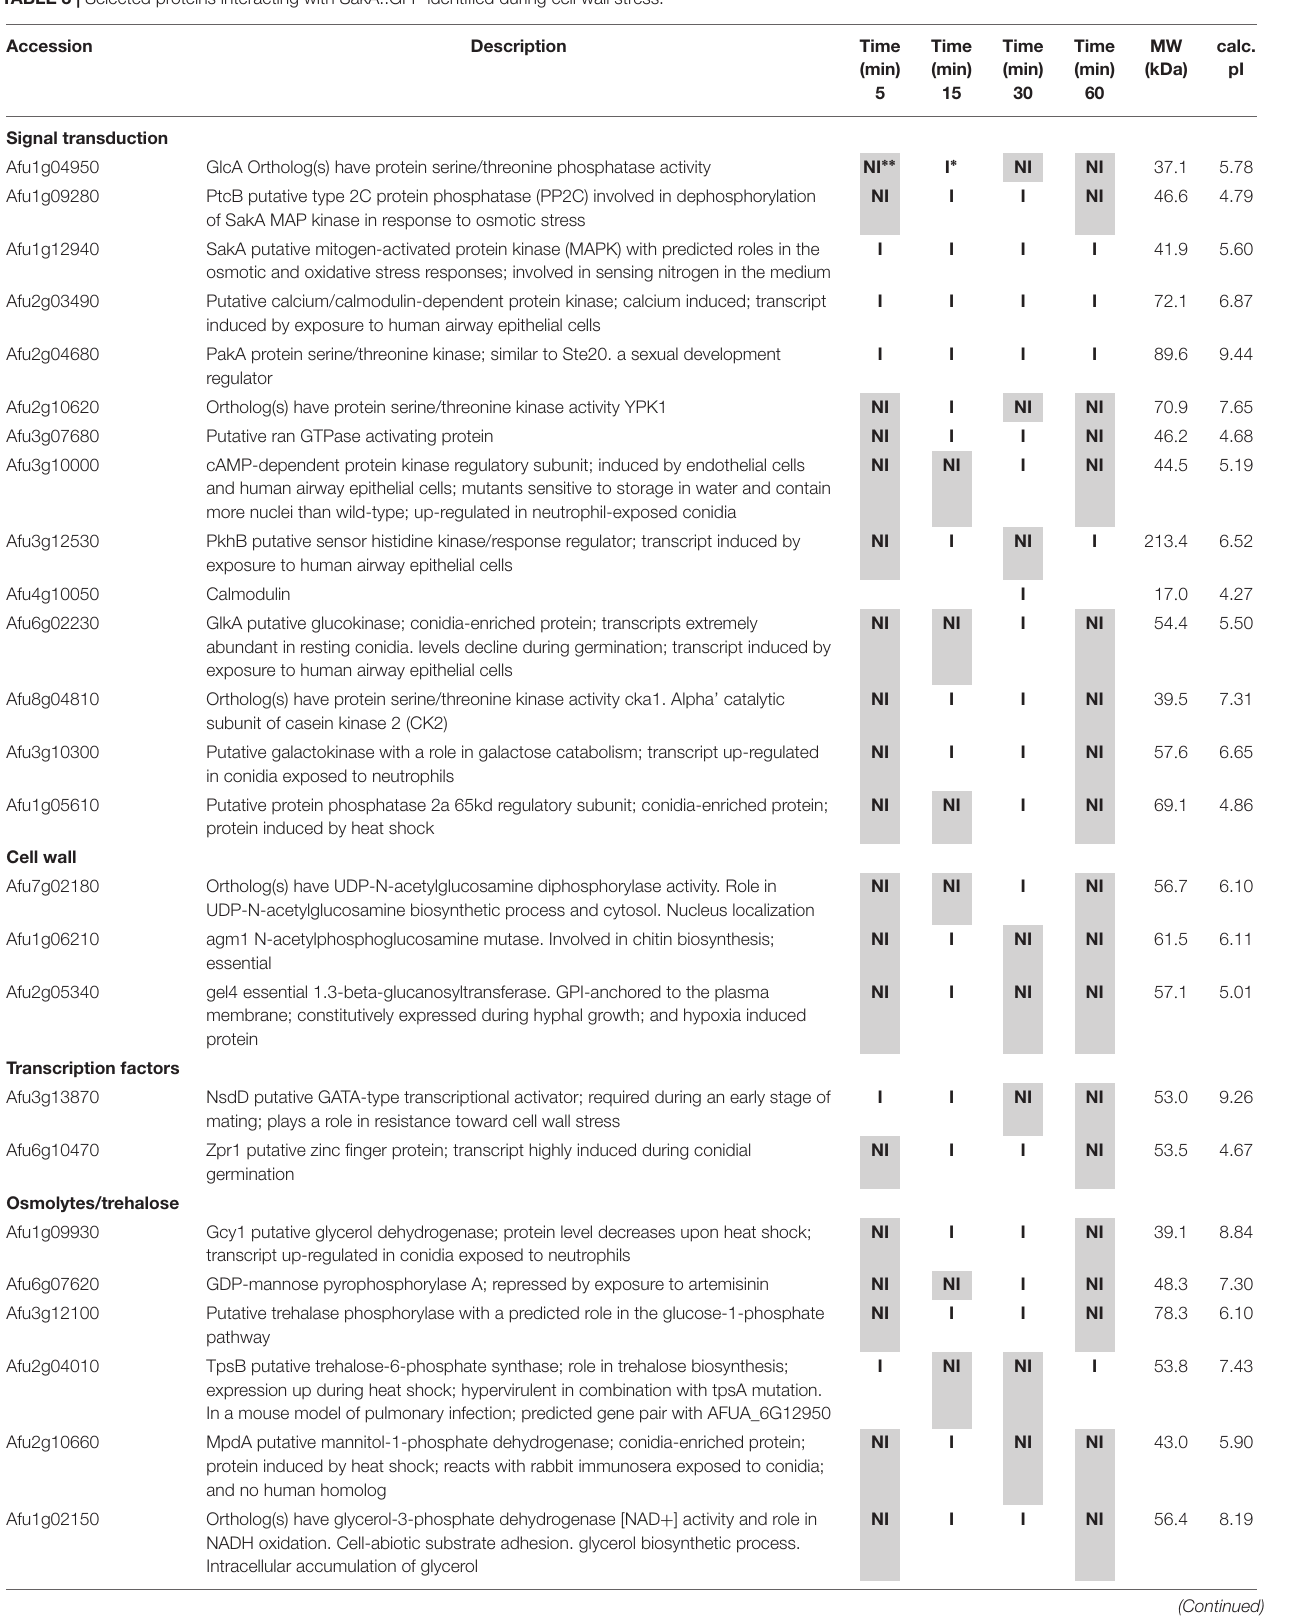
TpsB putative trehalose-6-phosphate synthase; role in trehalose biosynthesis; expression up during heat shock; hypervirulent in combination with tpsA mutation. In a mouse model of pulmonary infection; predicted gene pair with